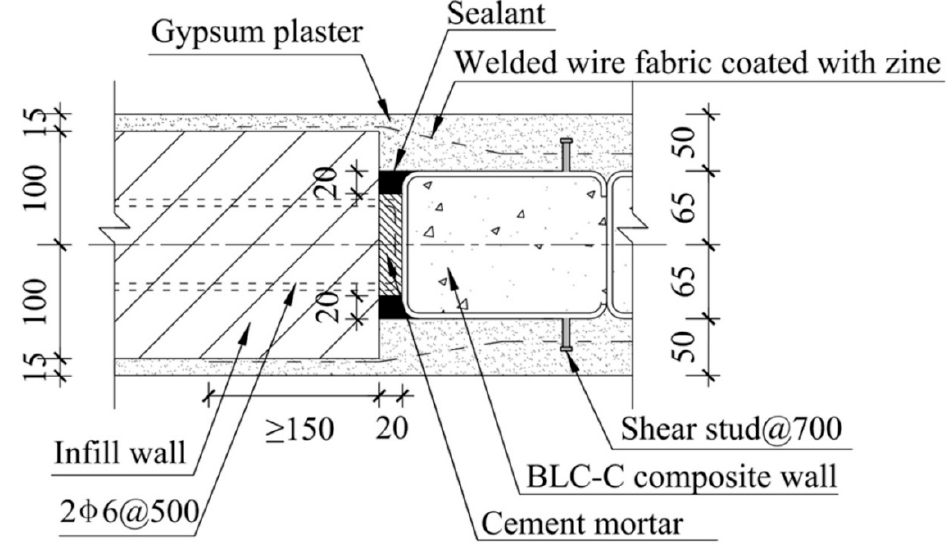
Figure 1. Connection structure of the interface (using cement mortar; units in mm).